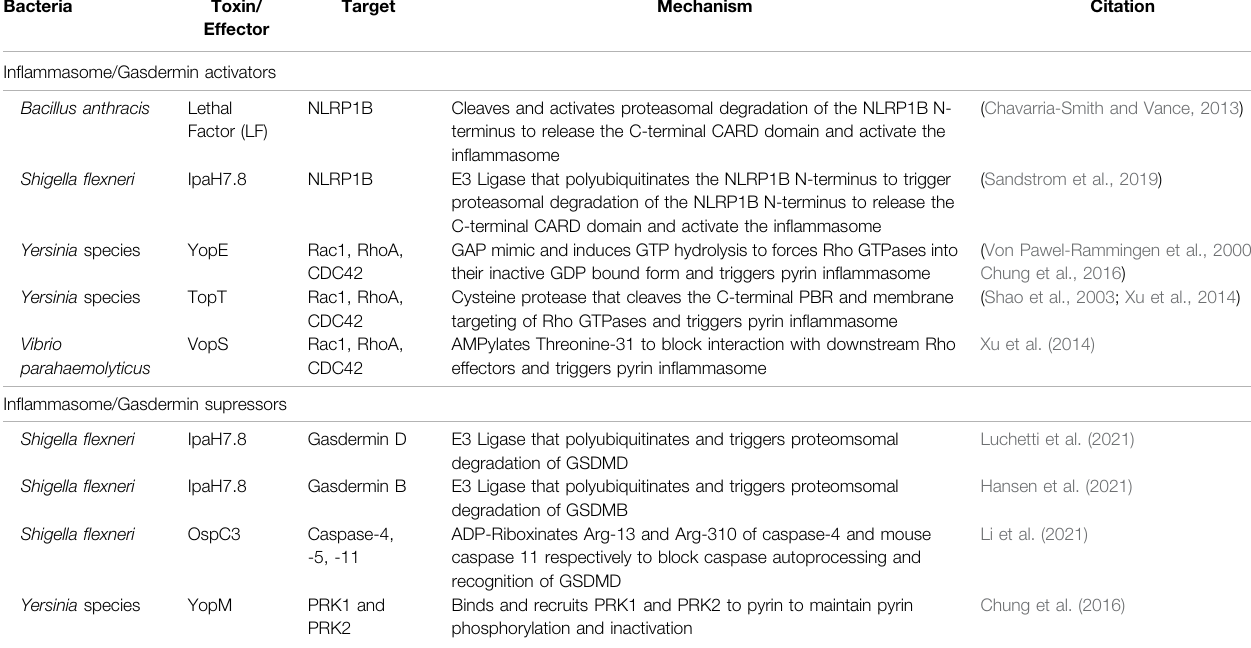
TABLE 2 | Toxin and effectors of intestinal pathogens that regulate In fl ammasome and Gasdermin.